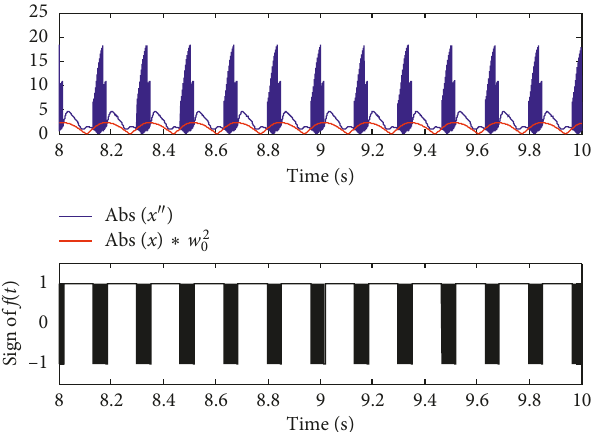
Figure 12: Results of F ( t ) frequency-range selector for the sem- iactive suspension when excitation frequency is 6 π